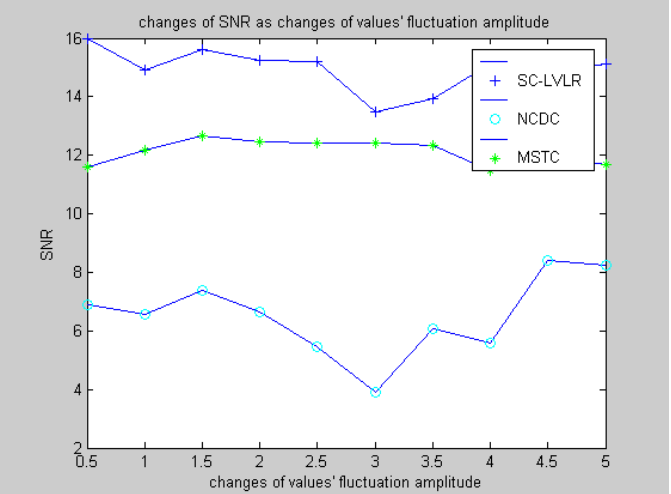
Figure 4. Changes of SNR with changes of values’ fluctuation